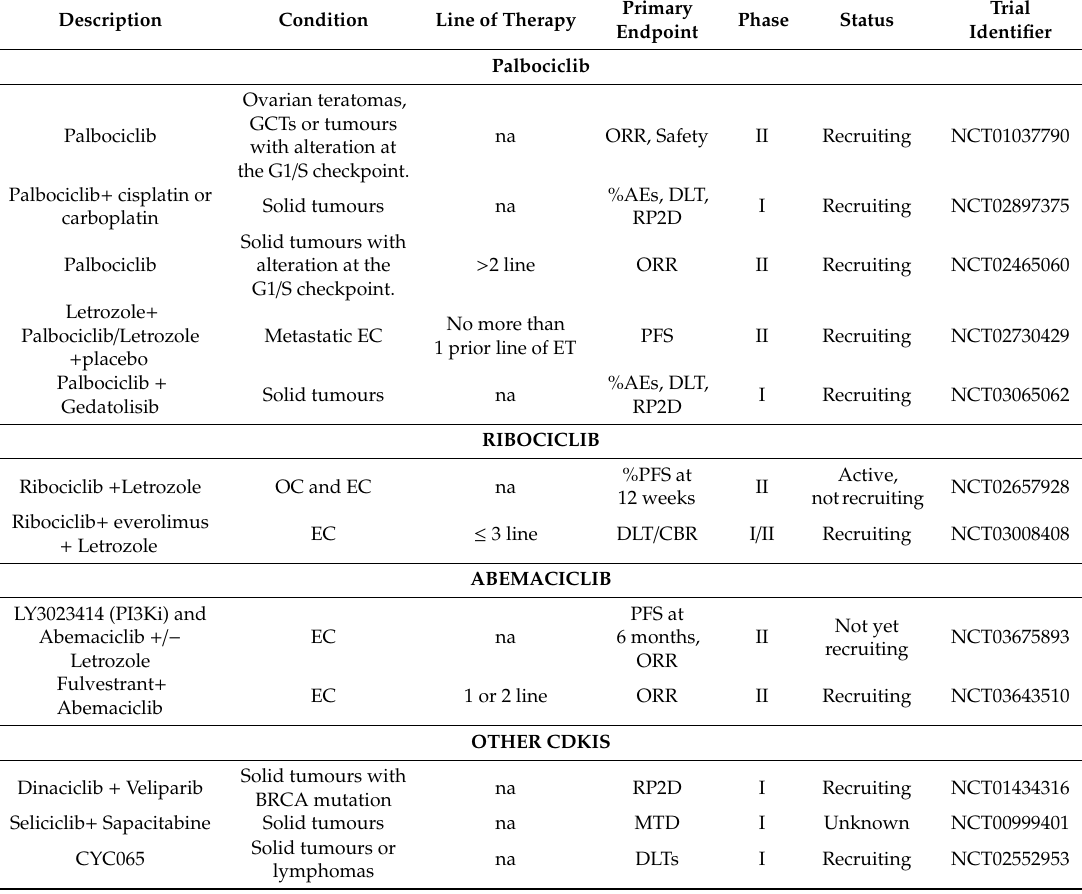
Table 2. Main ongoing clinical trials with CDKis in Endometrial